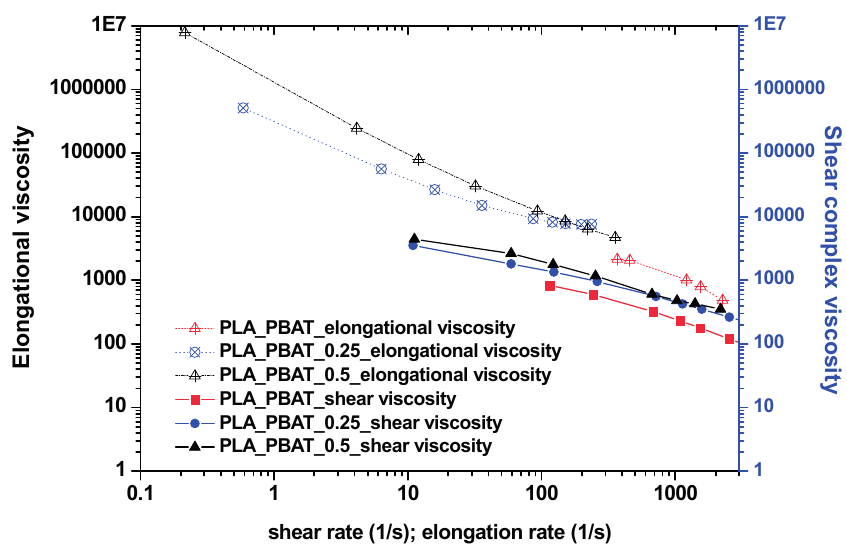
Figure 8. Elongational and shear viscosities versus elongation (and shear) rate for the non compatibilized and compatibilized PLA–PBAT blend at 180